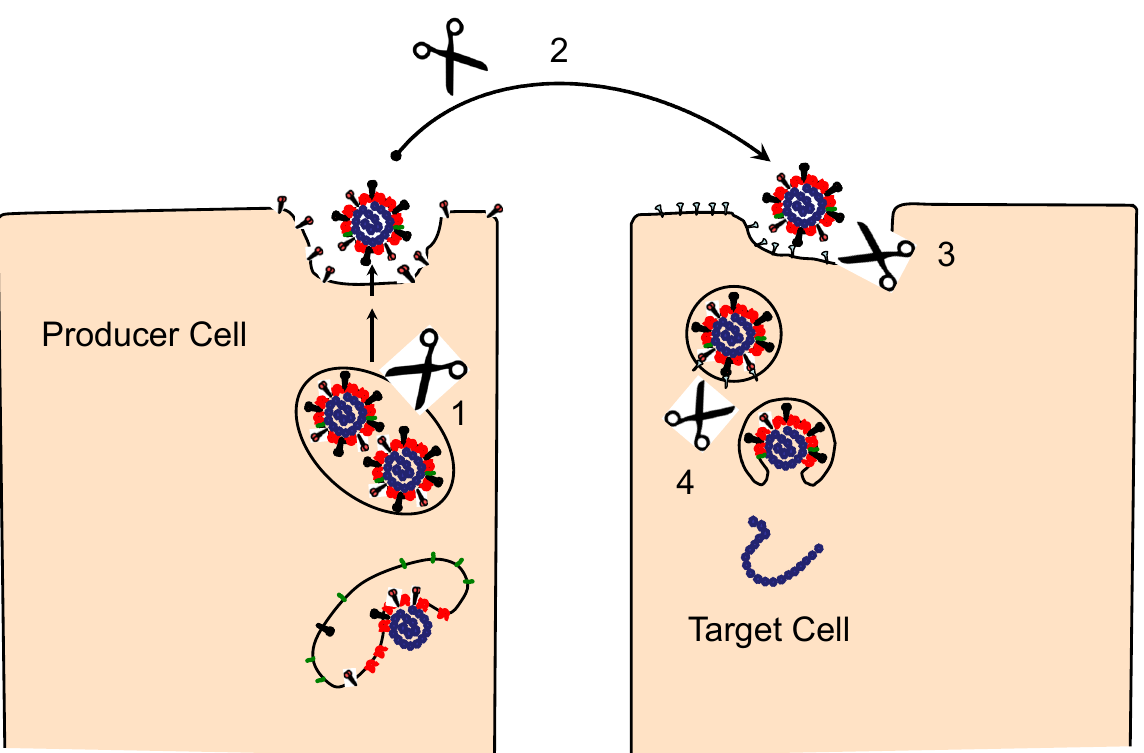
Figure 3. Proteolytic events during the CoV infection cycle. S cleavage events may take place during virus egress from producer cells (1), extracellular transit to target cells (2), on the target cell surface (3), and within the acidified endosome